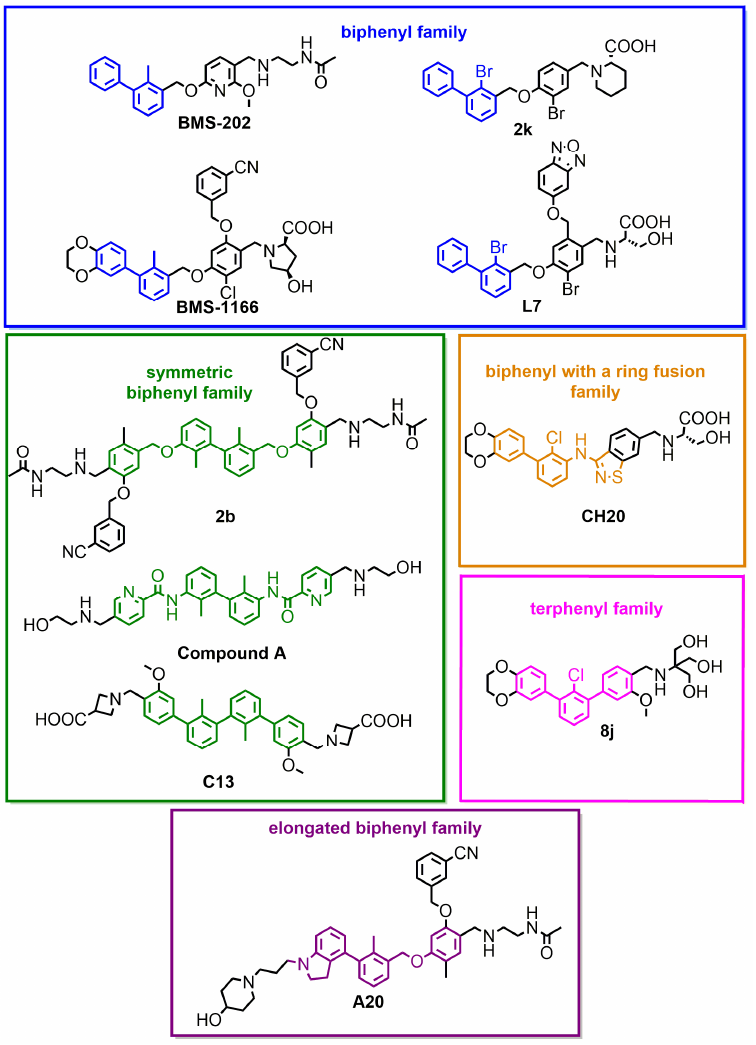
Figure 2. Small-molecule inhibitors of PD-L1, representative of different subclasses of the biphenyl superfamily.